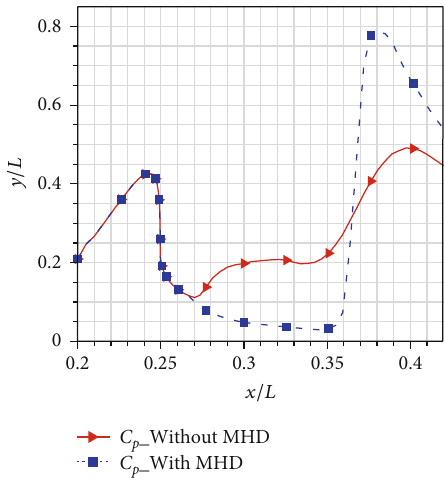
Figure 23: Wall pressure distribution in a 2D double wedge ramp hypersonic